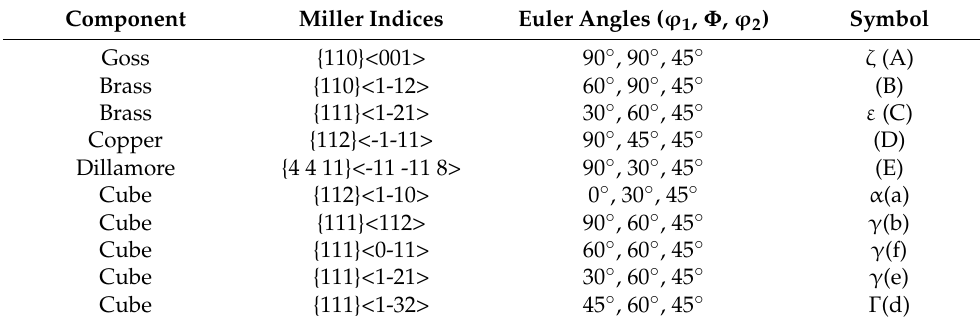
Table 1. Designation of the main cold rolling and recrystallizing texture components, and the corresponding Miller indices and Euler angles (Bunge